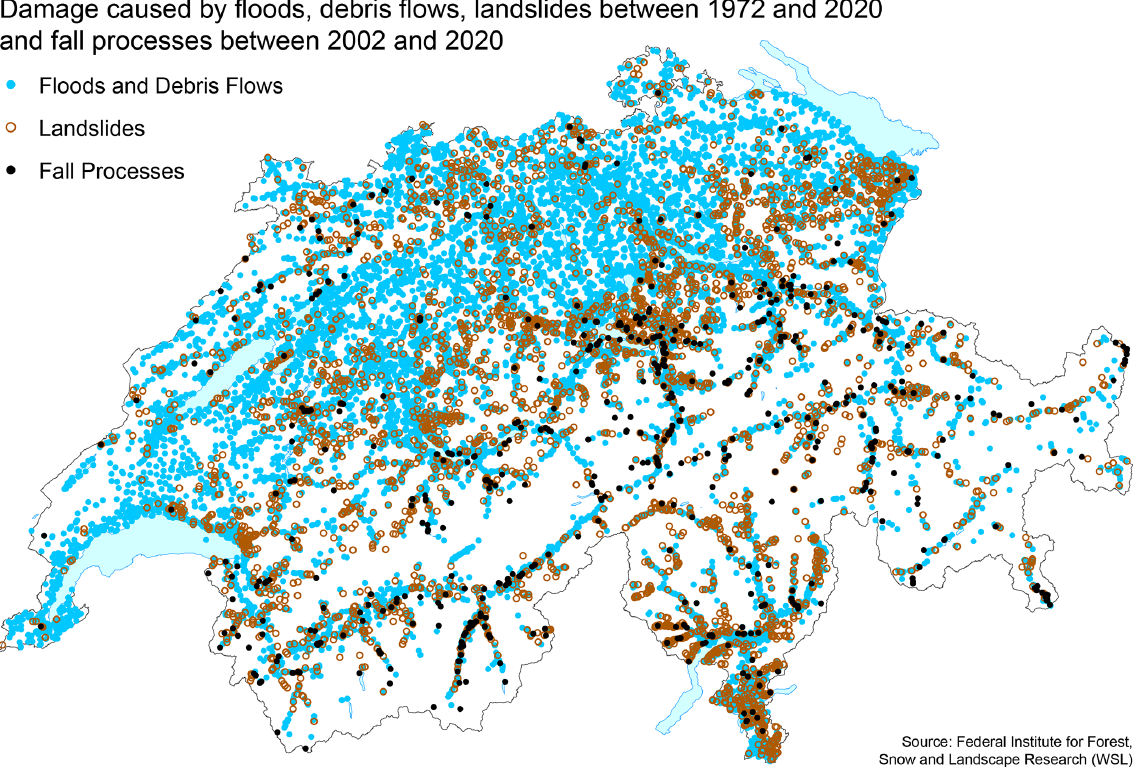
Figure 1. Damage caused by natural hazards in Switzerland. Federal Institute for Forest, Snow and Landscape Research (WSL,